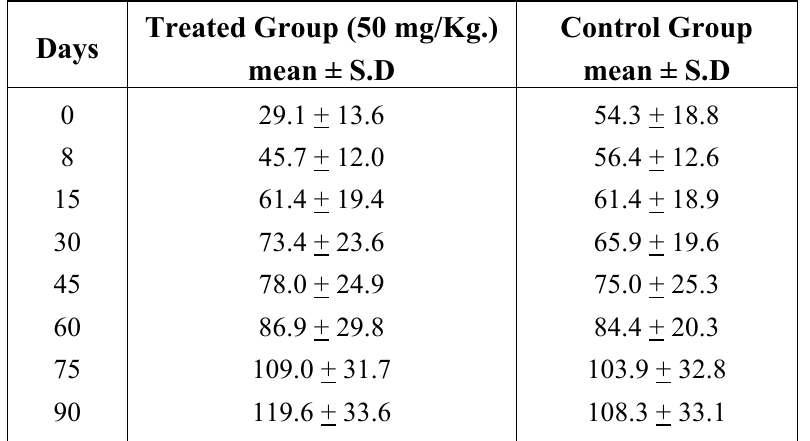
Table 3. Effect of 2-isopropyl-5-methylphenol on B. malayi microfilaraemia density per 10 µL of tail blood in treated and control animals on pre- (0th day) and post-treatment